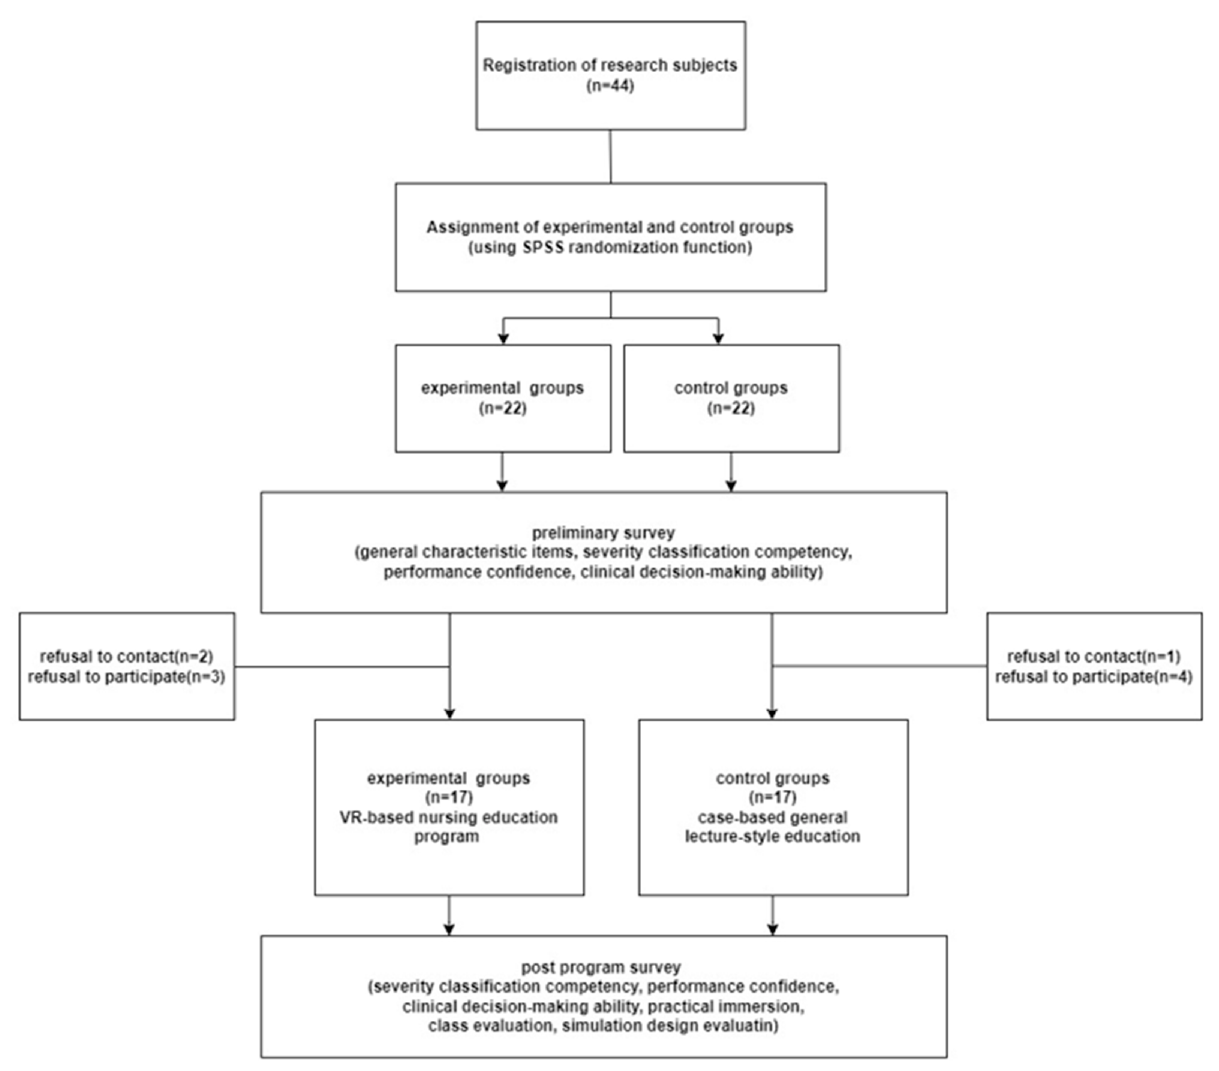
Figure 1. Flow chart of the study .